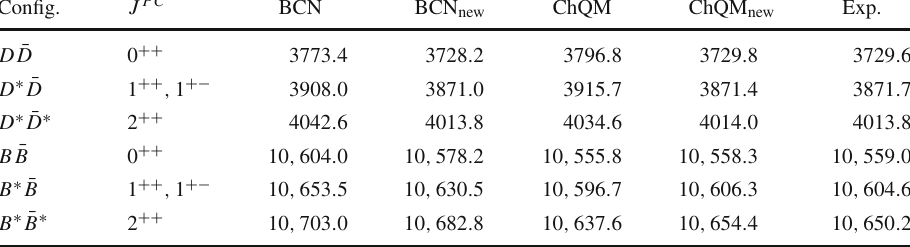
MeV) of S -wave D ( ∗ ) ¯ D ( ∗ ) and B ( ∗ ) ¯ B ( ∗ ) configurations